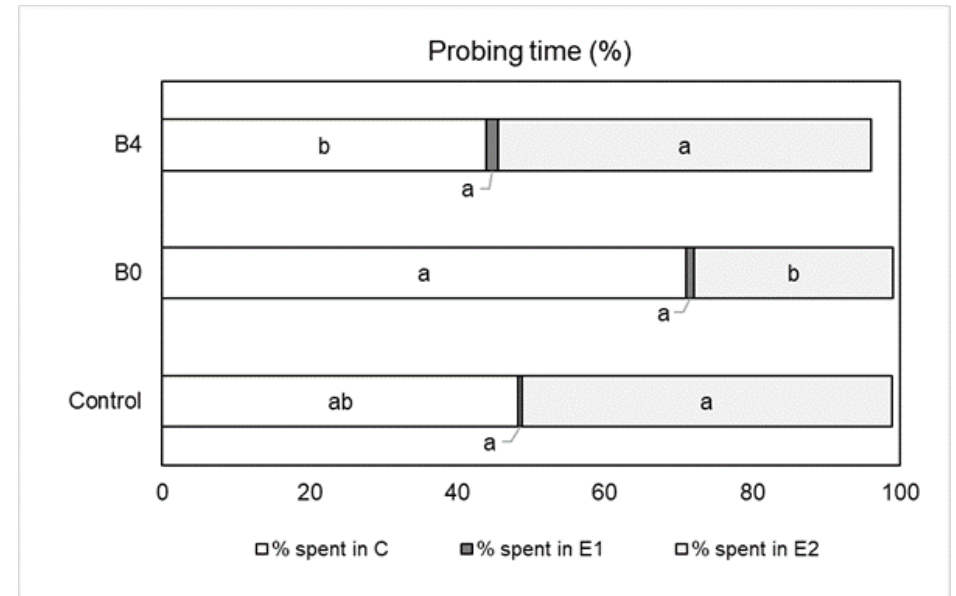
Figure 2. Percentage of probing time spent in a specific waveform when Aphis gossypii was fed on melon plants sprayed with BTH (benzo-(1,2,3)-thiadiazole-7-carbothioic-acid S-methyl ester) to the point of run-off, zero (B0) and four (B4) days prior to aphid first contact, using water-sprayed plants as control. Six-hour electrical penetration graph (EPG) recording. Waveforms: C , intercellular stylet pathway; E shows phloem-related activities: E1 , correlates with salivation into phloem sieve elements; E2 , regards as phloem ingestion [44]. Statistical comparisons among treatments for each parameter were made by non-parametric Kruskal–Wallis test. Means within variables followed by different lower-case letters are significantly different ( p- value < 0.05).